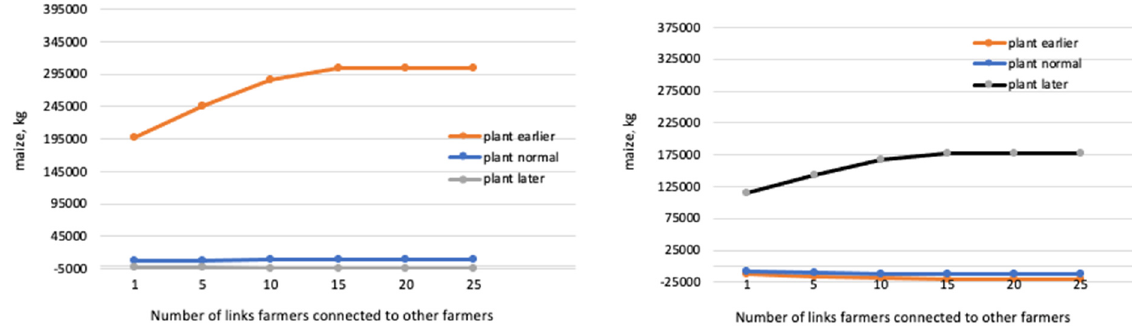
Figure 8. Farmers’ interactions with other farmers in their networks.